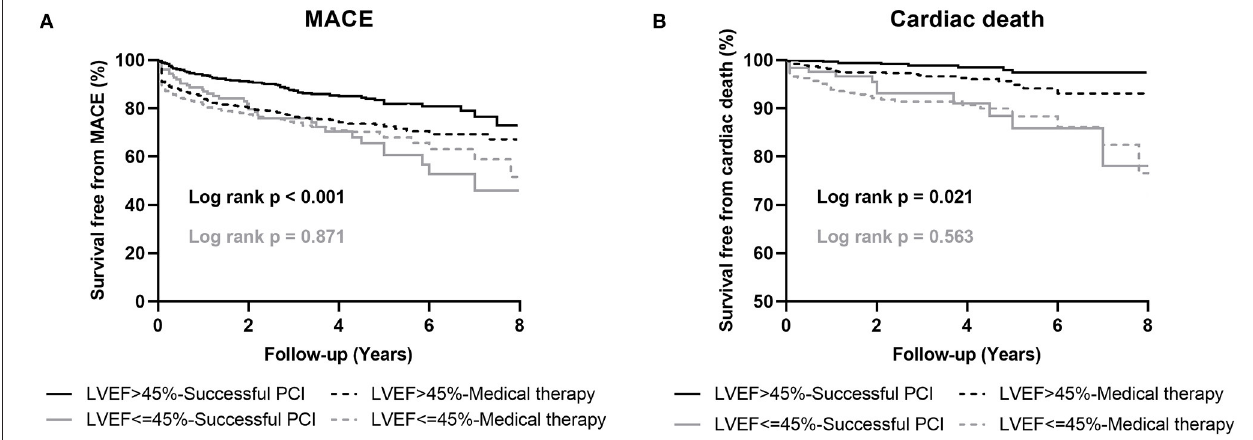
FIGURE 1 | Kaplan-Meier curves for MACE (A) and cardiac death (B) during follow-up for successful CTO-PCI vs. medical therapy in patients with and without left ventricular systolic dysfunction. LVEF, left ventricular ejection fraction; MACE, major adverse cardiovascular events; PCI, percutaneous coronary